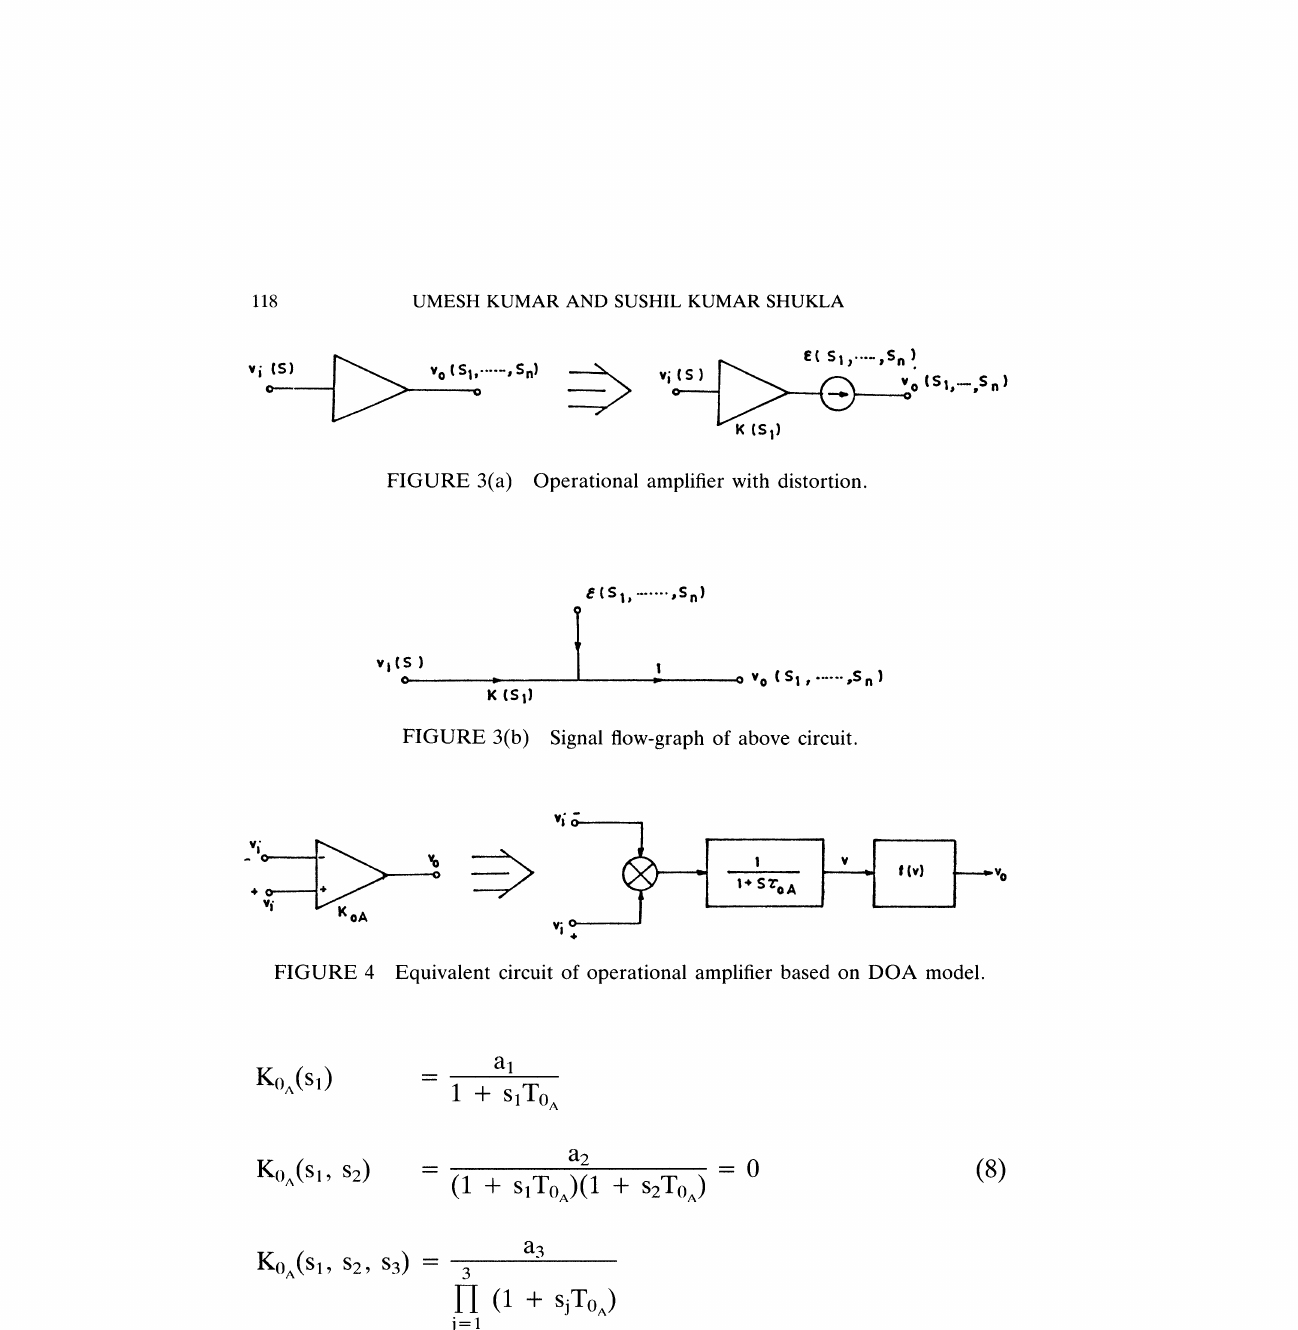
FIGURE 3(a) Operational amplifier with distortion.